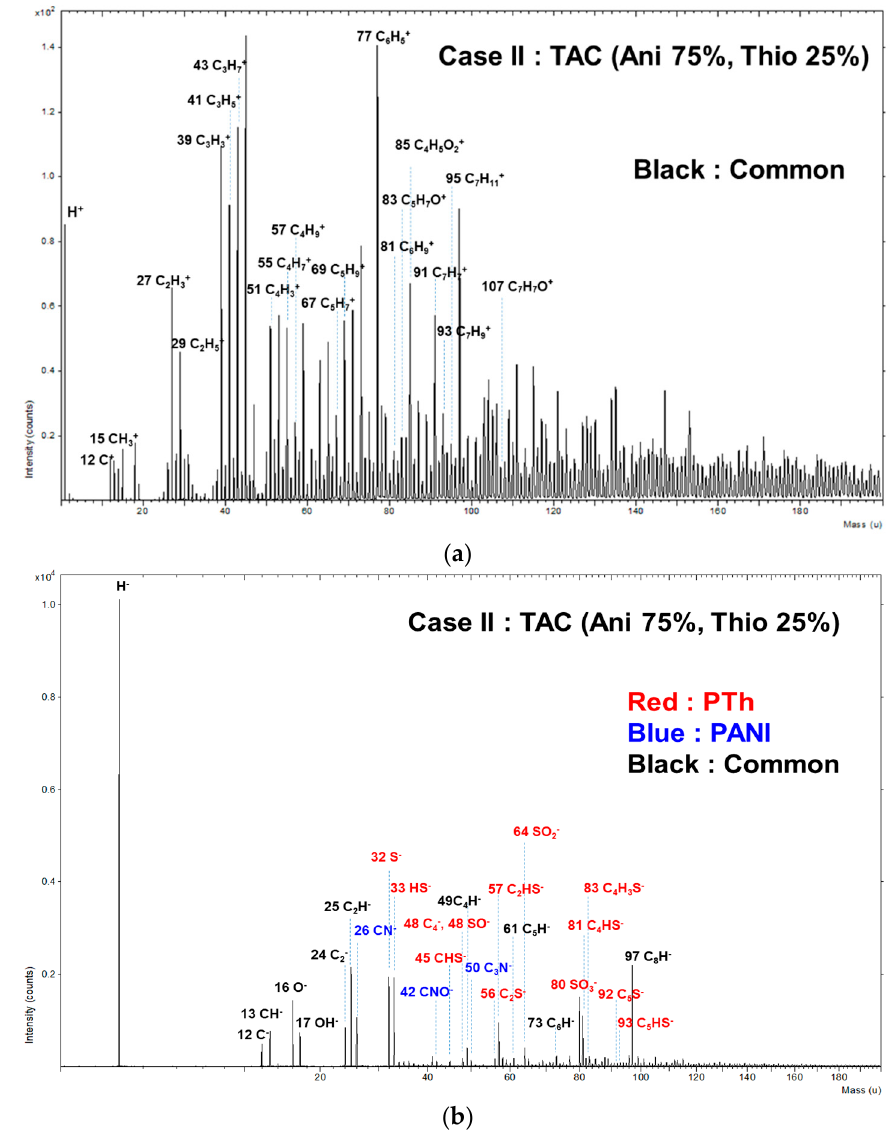
Figure 9. Positive-ion ( a ) and negative-ion ( b ) (0–200 amu) of ToF-SIMS on surface of TAC films deposited on glass substrates by APPJs polymerization at blending condition of case II (aniline 75% and thiophene 25%).